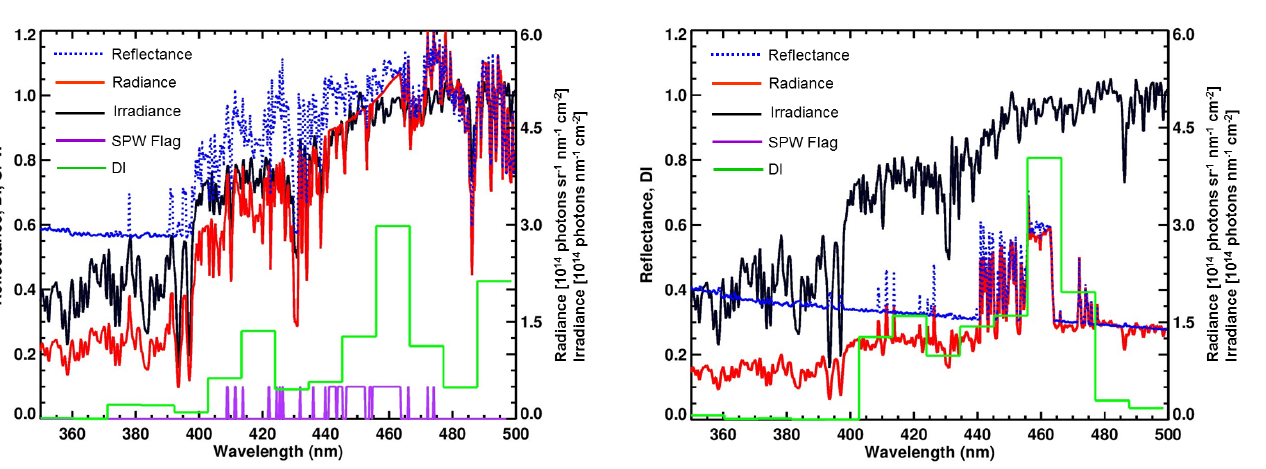
Figure 6. Similar to Fig. 5 but for pixel iTimes 823, row 11, orbit 7987 (see arrows in Fig. 4d). SPW flags are zero for this case and are not